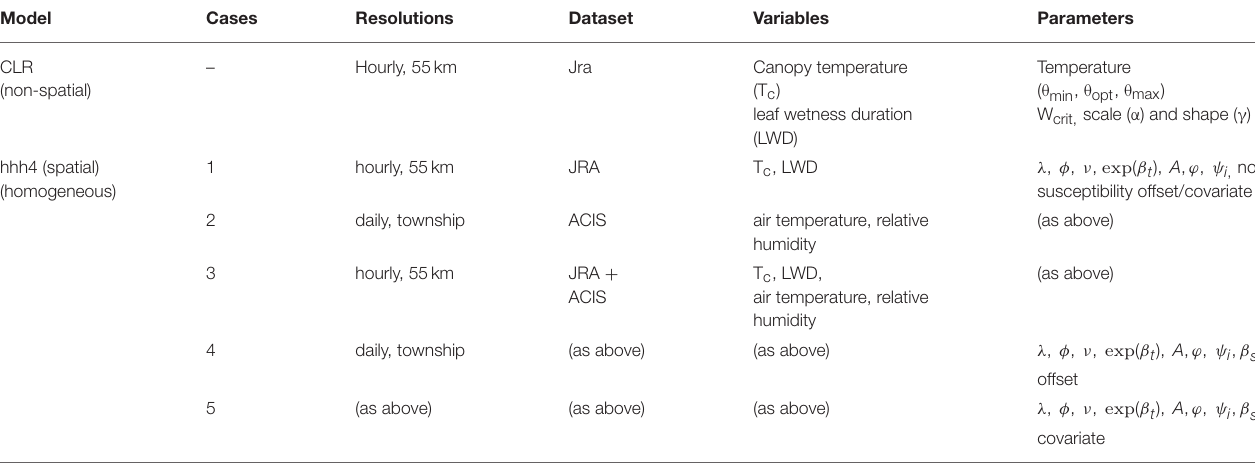
TABLE 1 | A summary of input datasets, climate variable inputs, fixed parameters, data and model spatial, and temporal